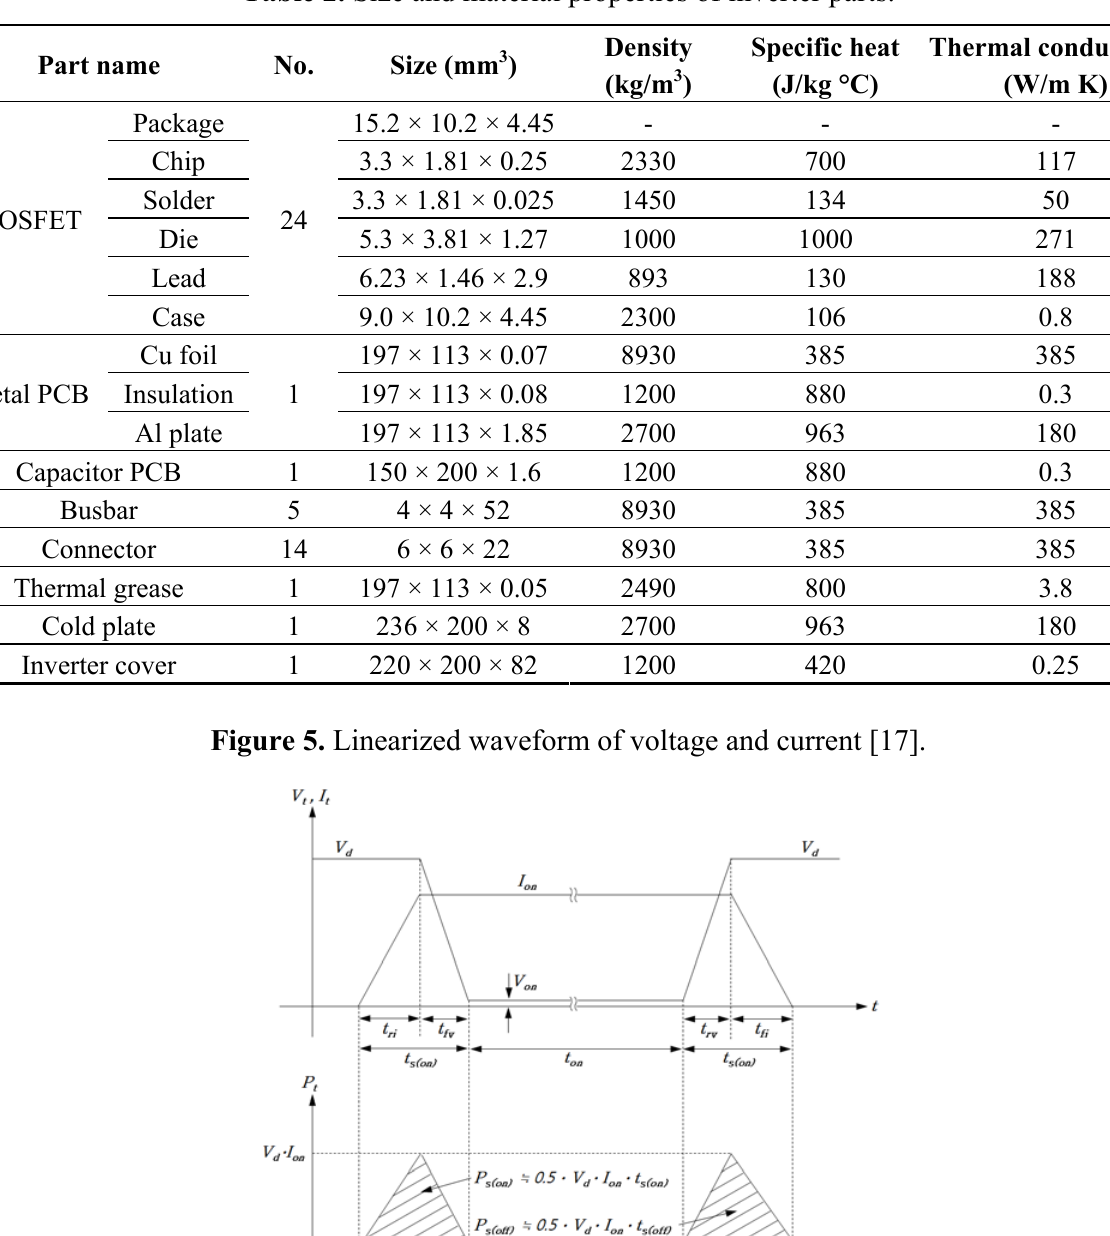
Table 2. Size and material properties of inverter parts.